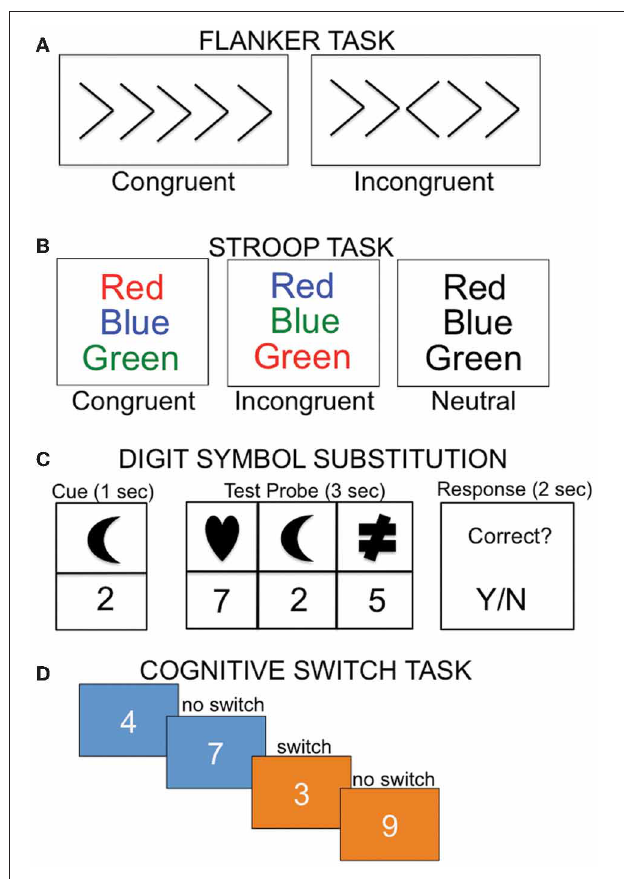
FIGURE 4 | Examples of cognitive tasks implemented in imaging studies examining the relationship between cardiorespiratory fitness and the brain. (A) During the flanker task, subjects must indicate the direction of the center arrow, with the incongruent condition requiring additional cognitive control relative to the congruent condition. (B) In the Stroop task, participants are instructed to read the color of the print. In the incongruent condition, participants must inhibit the automatic response of reading the word. (C) In the digit symbol task, participants are required to map the associated number-shape pairs. (D) During the cognitive switching task, subjects are asked to judge whether a number is odd or even when the background is blue, or bigger or smaller than five when the background is